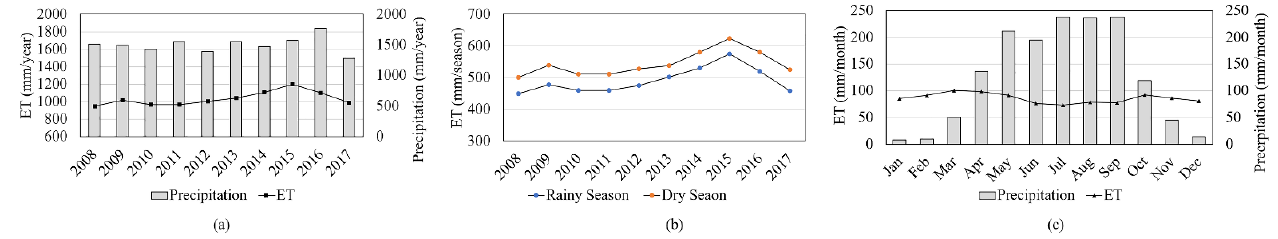
Figure 4. Temporal variation trend of ET. ( a ) The inter-annual trend of annul ET and precipitation from 2008 to 2017. ( b ) The rainy season ET and the dry season ET from 2008 to 2017. ( c ) The monthly trend of ET and precipitation from 2008 to